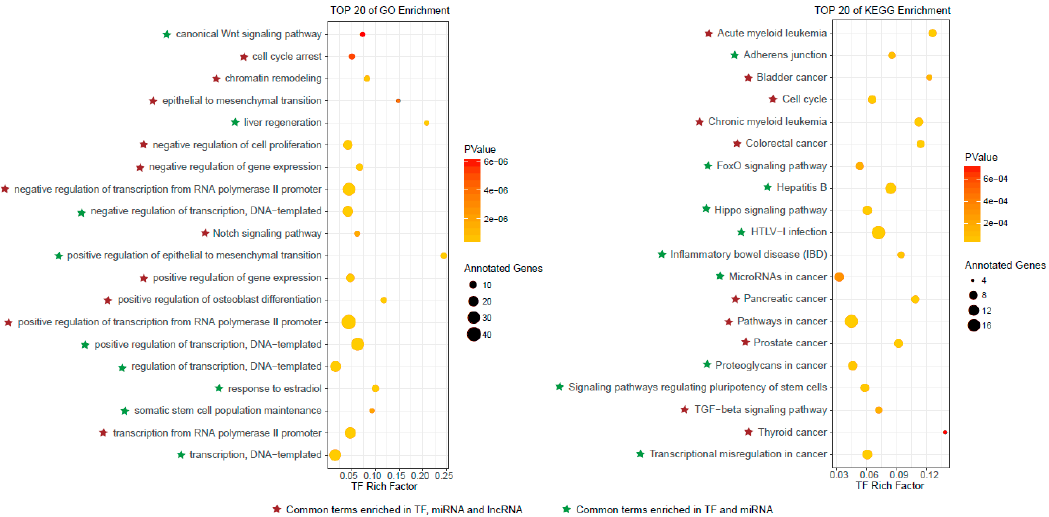
Figure 3. The top 20 Gene Ontology (GO) enrichment and Kyoto Encyclopedia of Genes and Genomes (KEGG) enrichment results for top ranked TFs. The common enriched GO terms and KEGG pathways among top ranked TFs, miRNAs and lncRNAs are marked.